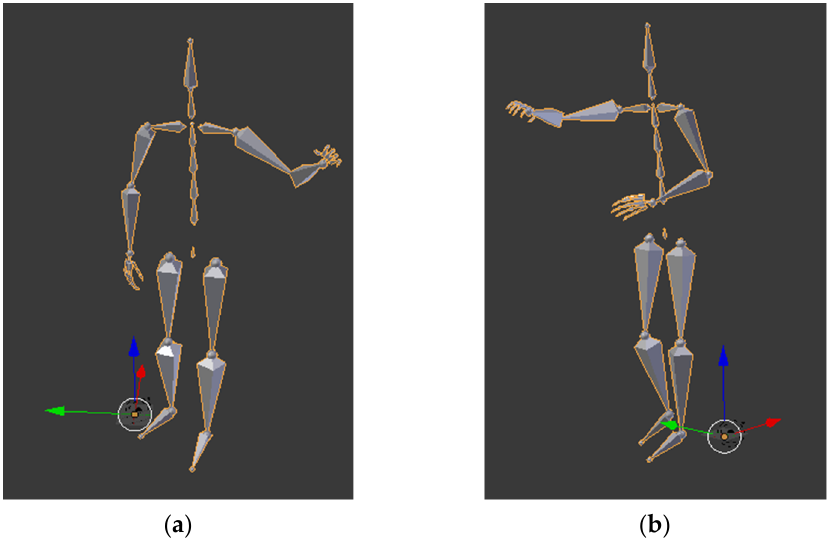
Figure 2. InHARD skeleton preview in Blender: ( a ) picking left ( b ), picking in front.